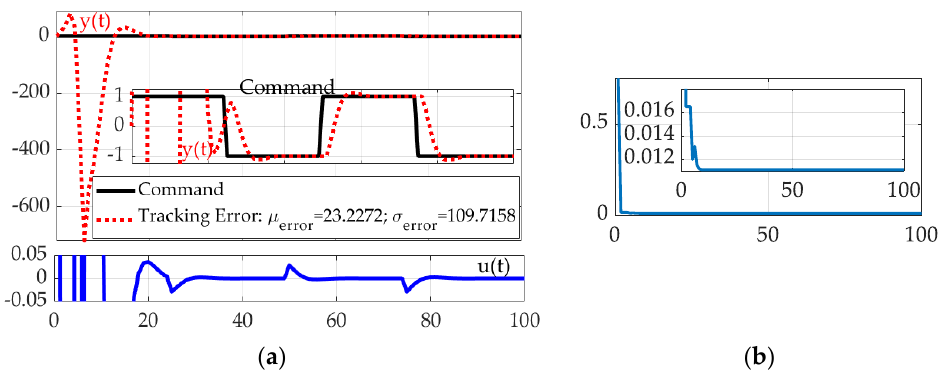
Figure 5. Indirect self-tuner without process zero cancellation (non-minimum phase plant) with timesteps on the abscissa. ( a ) Command and actual output (top); and control (bottom). ( b ) Gain 𝛽 .